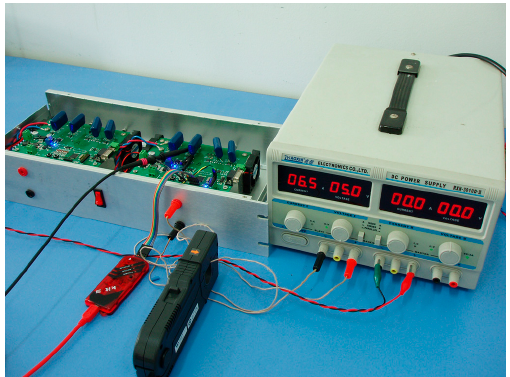
Figure 16. Low-power electronic load test bed.